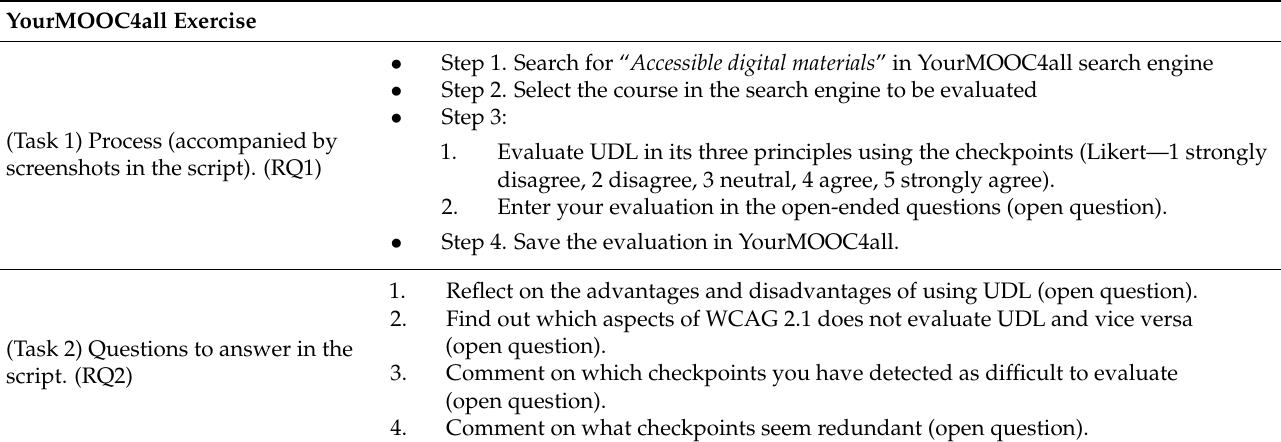
Table 1. YourMOOC4all exercise